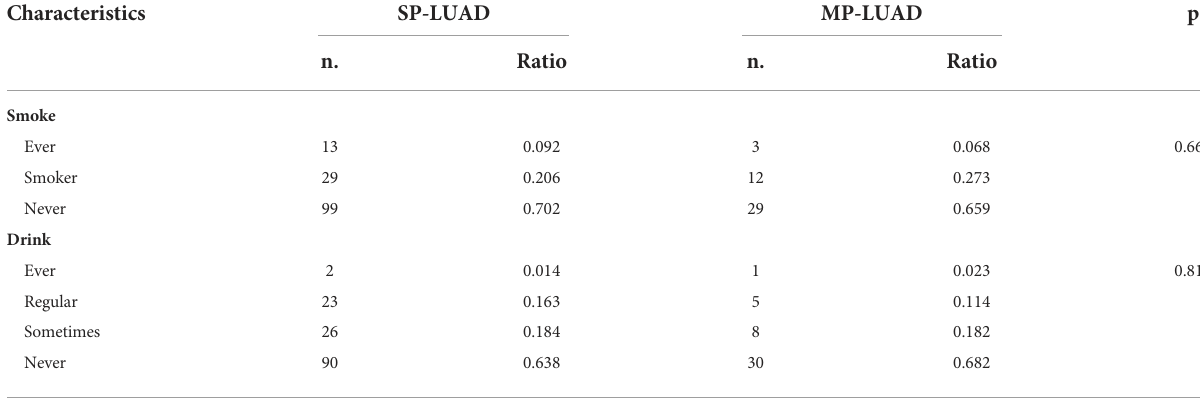
TABLE 3 Clinical correlation analysis of smoking and drinking.